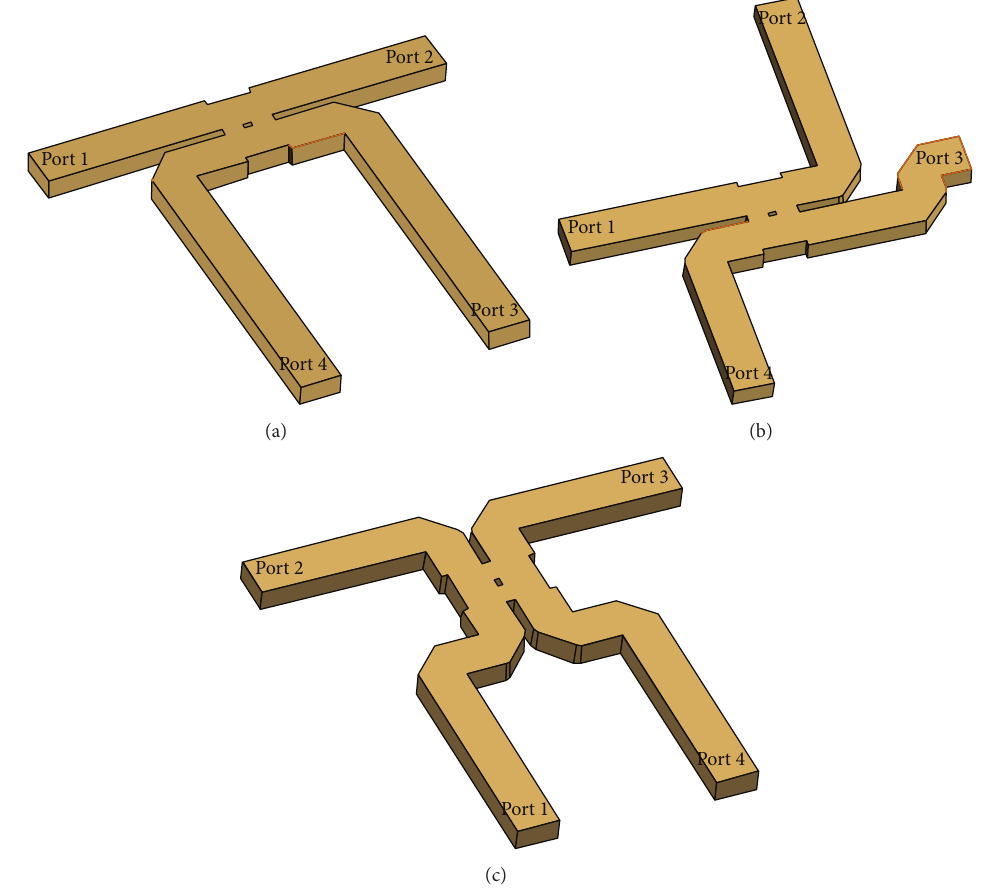
Figure 4: Testing topologies of the proposed coupler. (a) The through coupling topology (for testing the through coupling characteristic, in which the under test ports (port 1 and port 2) are set in a line and the untested ports (port 3 and port 4) are turned to the orthogonal direction). (b) The parallel coupling topology (for testing the coupling coefficient, in which the under test ports (port 1 and port 3) are set in a line and the untested ports (port 2 and port 4) are turned to the orthogonal direction). (c) The isolation topology (for testing the isolation characteristic, in which the under test ports (port 2 and port 3) are set in a line and the untested ports (port 1 and port 4) are turned to the orthogonal